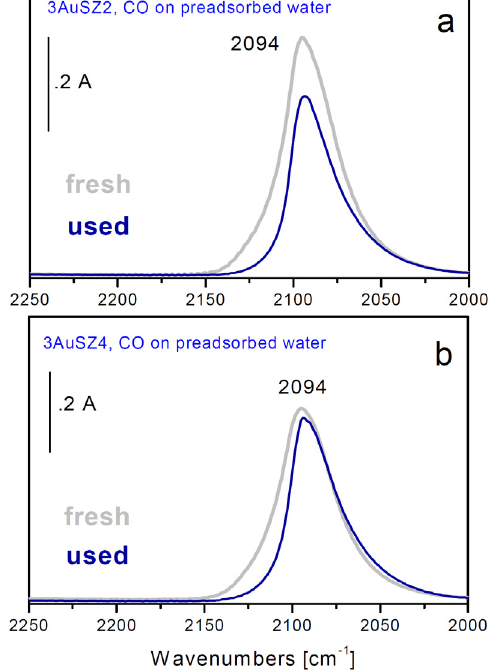
Figure 5. FTIR difference spectra of CO adsorbed at 157 K on fresh (grey curves) and used (blue curves) 3AuSZ2 ( a ) and 3AuSZ4 ( b ) catalysts precovered previously by